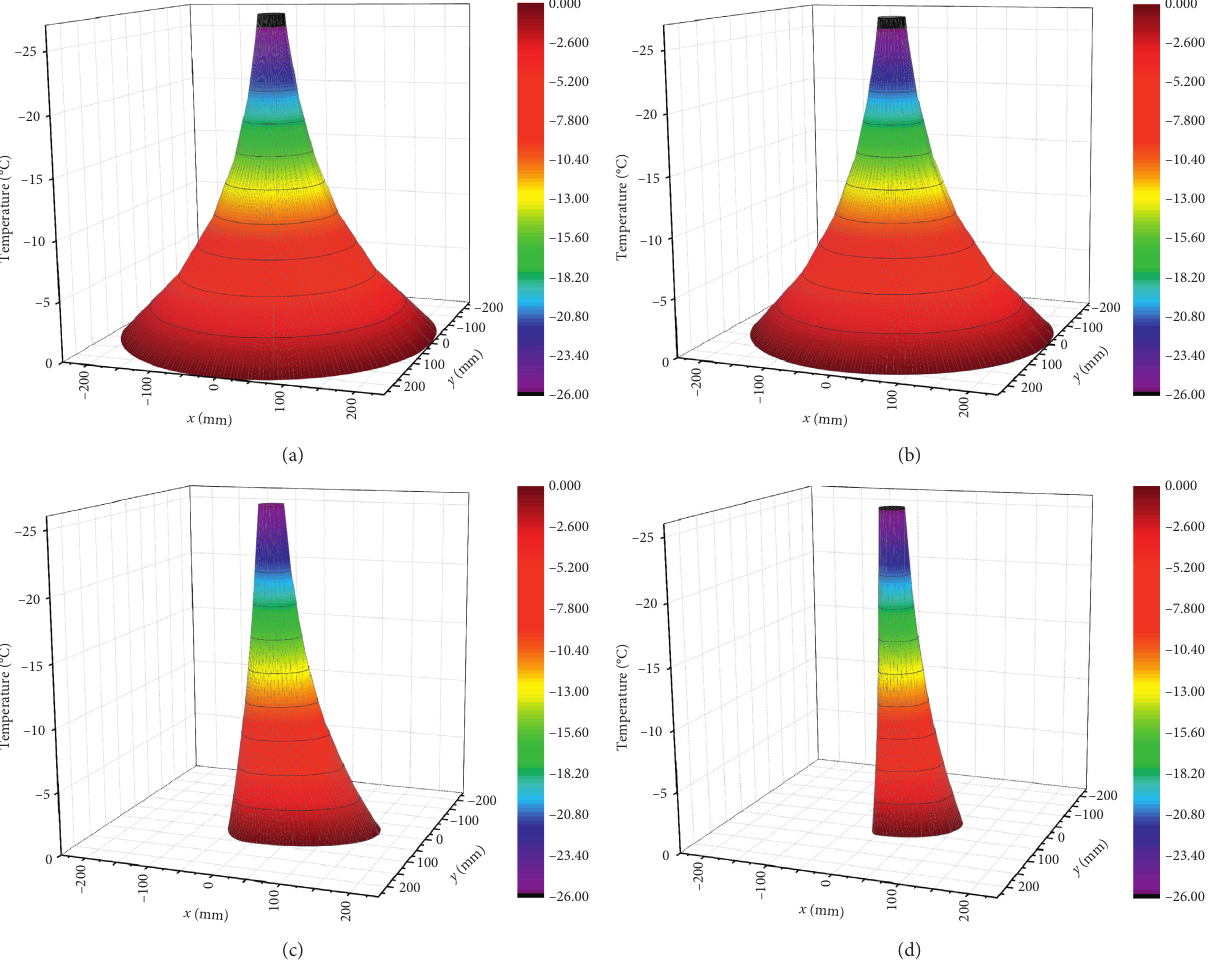
Figure 7: Overall distribution of steady-state freezing temperature field under the action of seepage field with a flow rate of (a) 0, (b) 3, (c) 6, and (d)